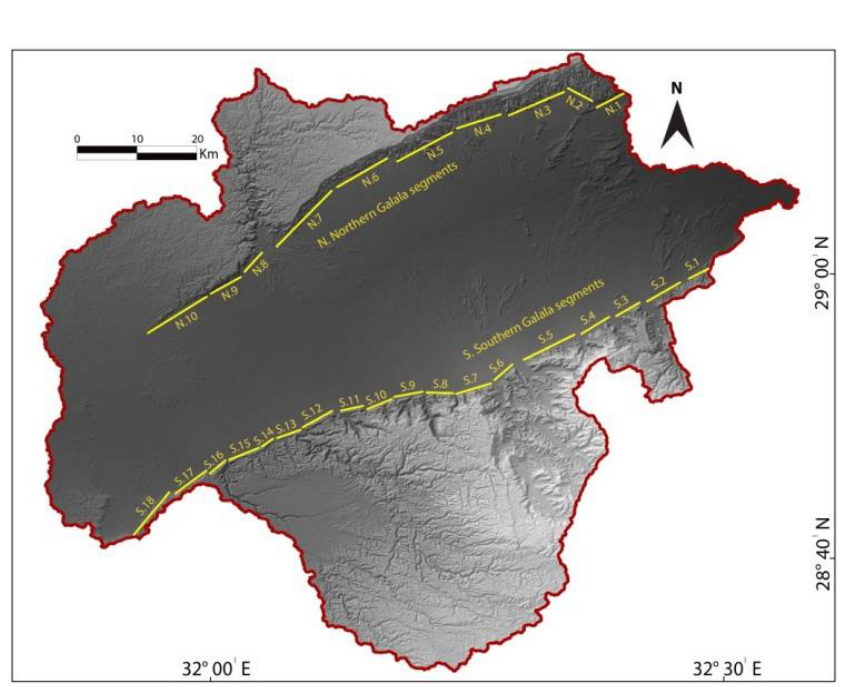
Figure 7. Segments of the Northern and Southern Galala Plateaus. Table 1. Values of the mountain front sinuosity and valley floor width to valley floor height ratio of the study segments; the average classes of relative activity are presented as well. N: Northern Galala Plateau and S: Southern Galala Plateau.